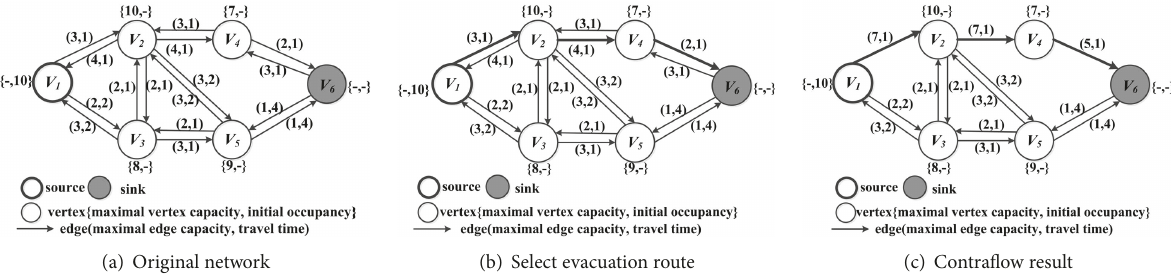
Figure 3: Example of the proposed contraflow-based